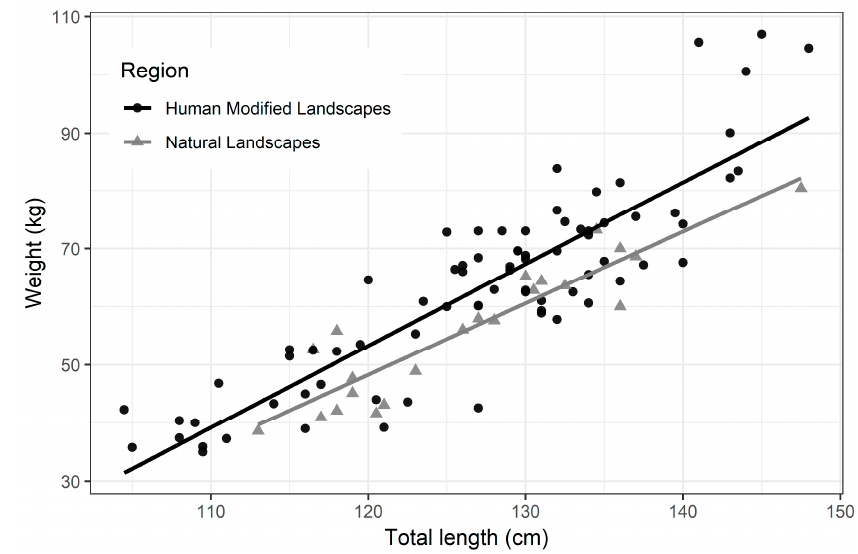
Figure 4. Graphical representation of the distribution of body mass in relation to the total body length of adult capybaras from human-modified landscapes and natural landscapes in Brazil. Data were significantly different (linear regression; p = 0.001) between HML and NL.